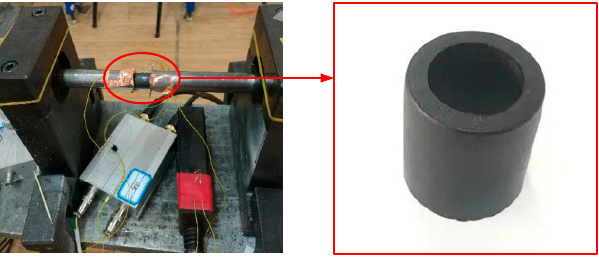
Figure 2. Experimental samples and installation diagram.